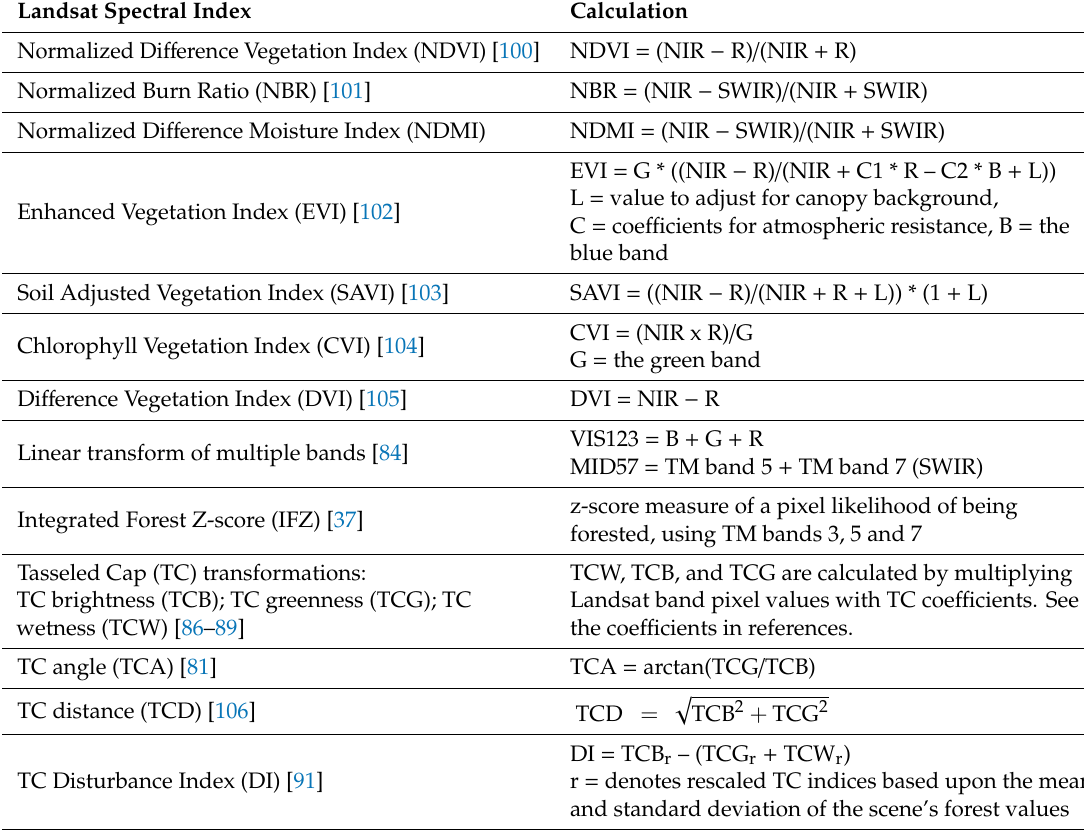
Table A1. Landsat spectral indices commonly used for forest AGB